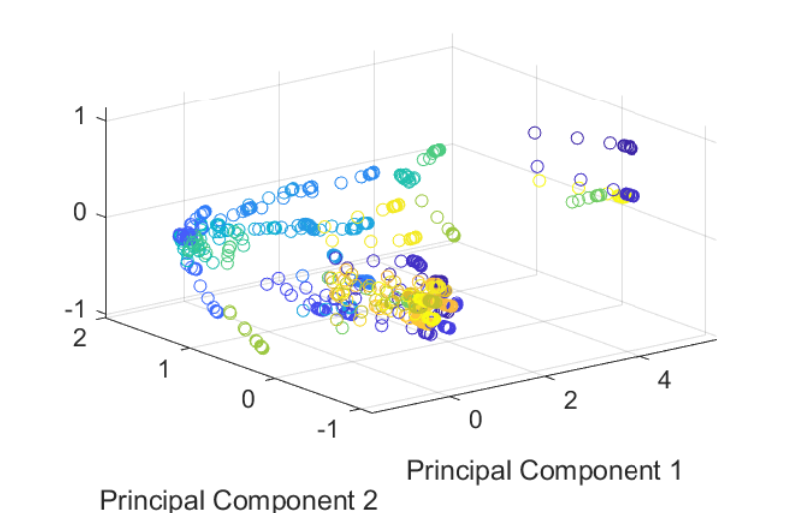
Figure 18. Principal Components Analysis